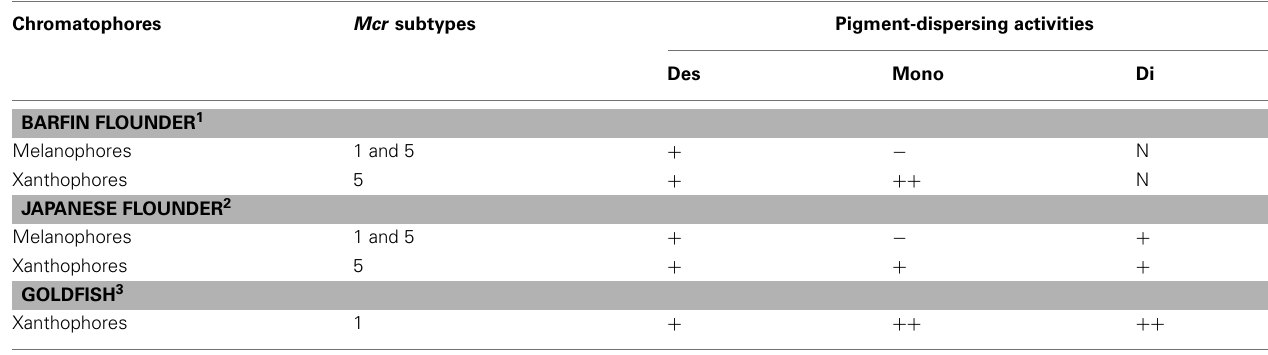
Table 1 | Mcr subtypes expressed in fish chromatophores and pigment-dispersing activities of α -MSH-related peptides in these cells. Chromatophores Mcr subtypes Pigment-dispersing activities Des